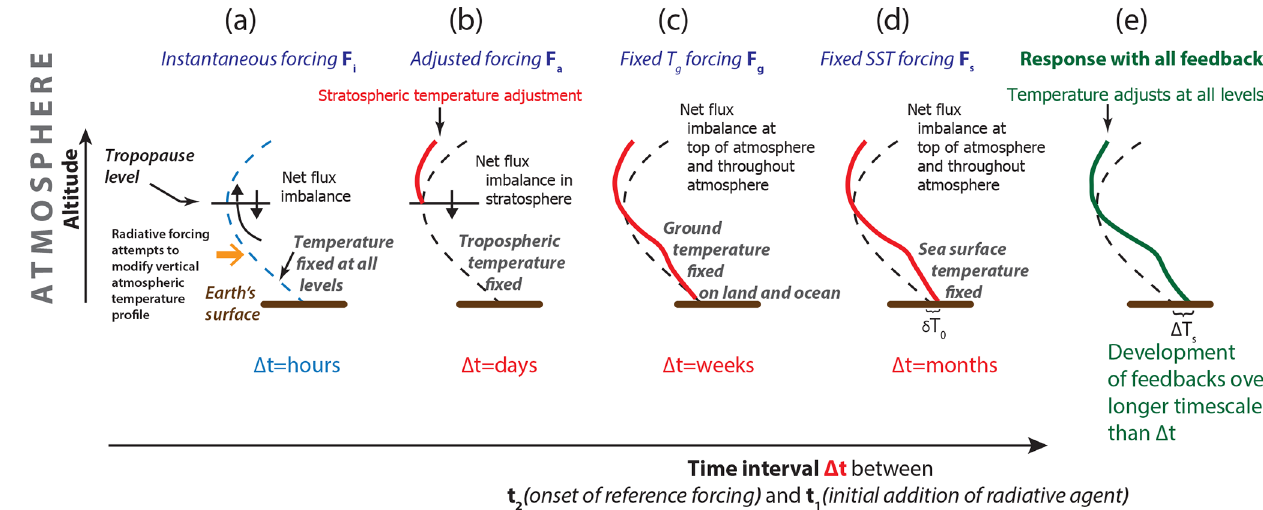
Figure 4. Sketch illustrating the different definitions of forcing (drawn anew and extended following Myhre et al., 2013, and Hansen et al., 2005). (a) Instantaneous forcing. (b) Forcing at tropopause with only stratospheric temperatures adjusted (corresponding to RF). (c) Fixed ground temperature forcing. (d) Fixed SST forcing including adjustment of land temperature and atmospheric temperature (corresponding to ERF). (e) Full response including all feedbacks, also the slow